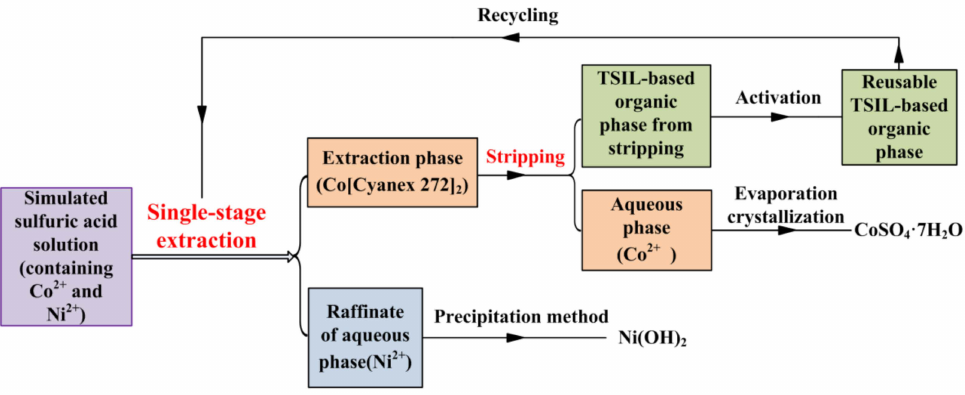
Figure 7. Recycling use of TSIL-based extraction phase.